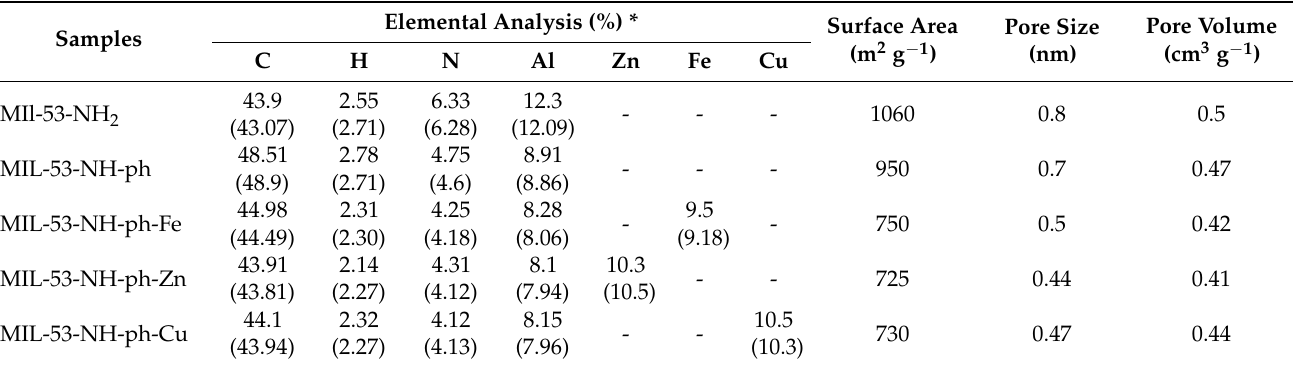
Table 2. Elemental characteristics and surface properties of MIl-53-NH 2 , MIL-53-NH-ph,